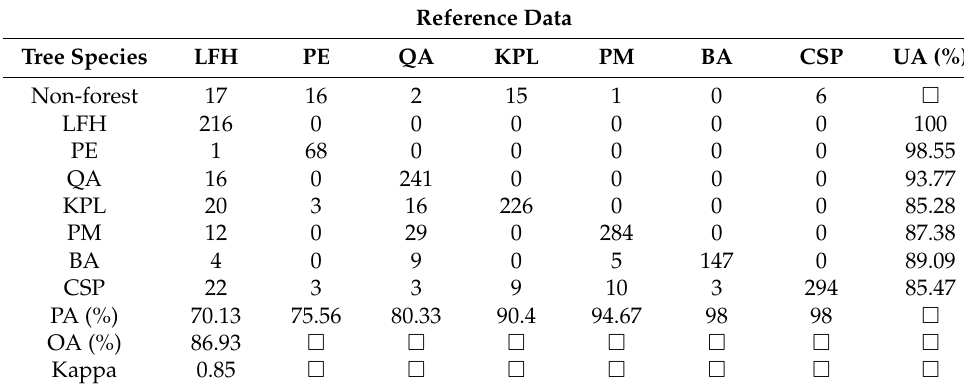
Table 6. Confusion matrix of Scheme